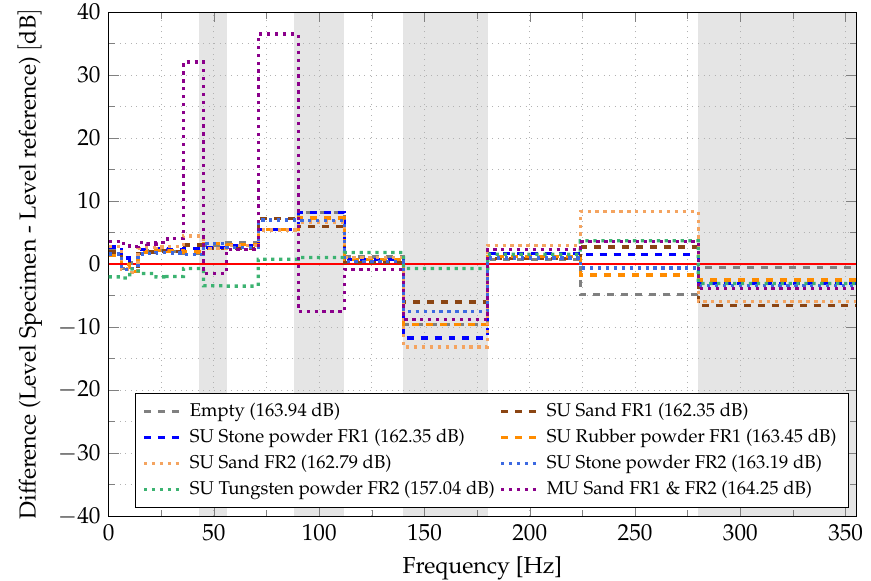
Figure A8. Difference in One-third octave band: FRF of SU and MU HCDP mounted between stator arm and stator ring with surface velocity in dB.